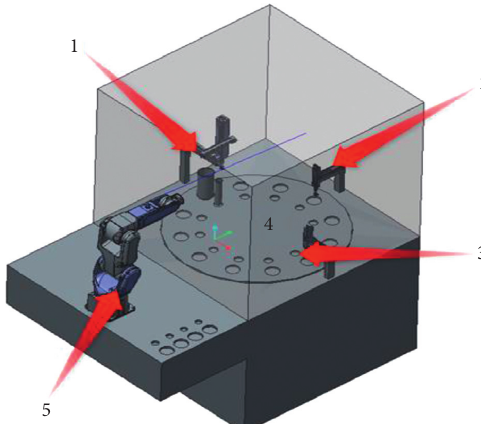
Figure 1: The concept of the set-up presenting the issues of In- dustry 4.0; pneumatic servo-manipulator, 1; pneumatic manipu- lators with vision system, 2; pneumatic manipulators, 3; the indexing table with slots for discs and RFID system, 4; the col- laborating robot, 5.